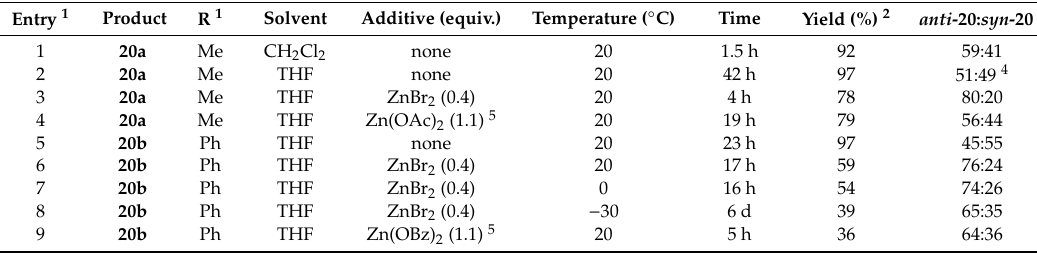
Table 2. Optimization of the stereoselective Passerini reaction.